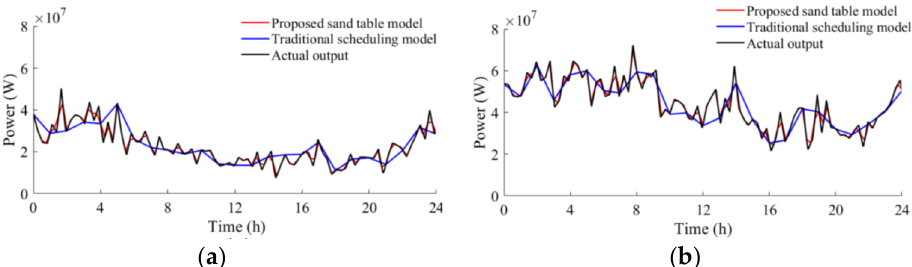
Figure 8. The deduced ultra-short-term predicted output of the wind power model: ( a ) typical summer day; ( b ) typical winter day.